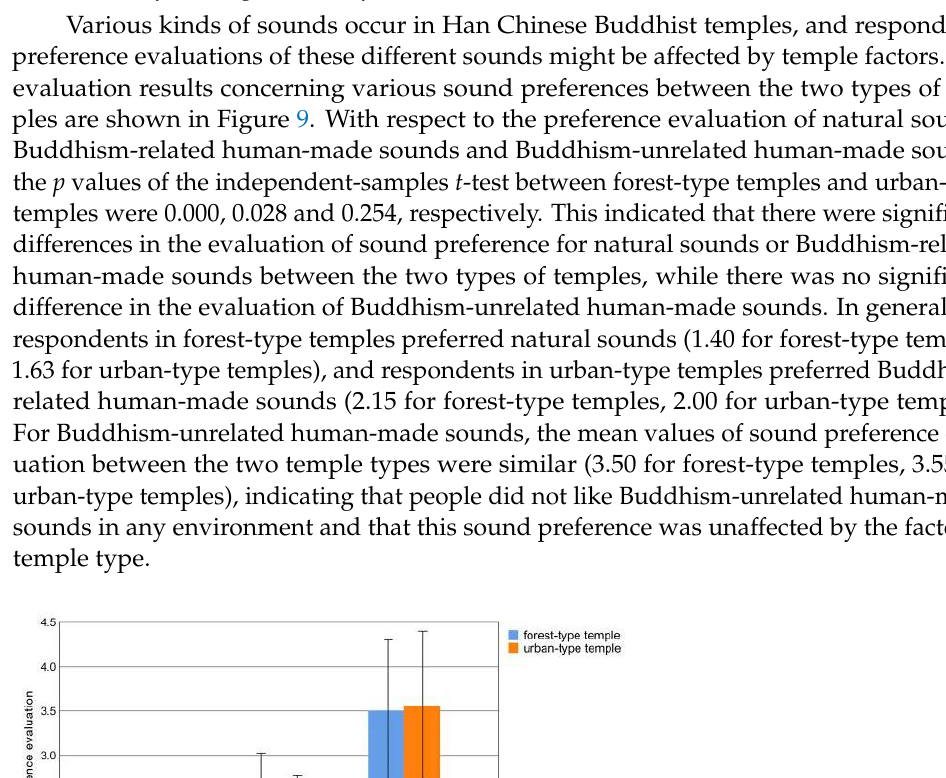
Figure 10. The evaluation value and standard deviation of sound preference for the five sounds with significant differences between the two types of temples. 3.3. Discussion 3.3.1. Comparison among Various Influencing Factors on Acoustic Environment Evalua- tion (1) As shown in Figure 11, in forest-type temples, the three factors that had the most significant effect on the evaluation of acoustic comfort and harmony were attitudes to- wards Buddhist thought > education > age. The factors that had the most significant effect on the evaluation of acoustic quietness were education level > age > occupation. In urban- type temples, the three factors that had the most significant effect on the evaluation of acoustic comfort were attitudes towards Buddhist thought > frequency of visits to the temple per year > measured sound levels synchronous with the questionnaire; the factors